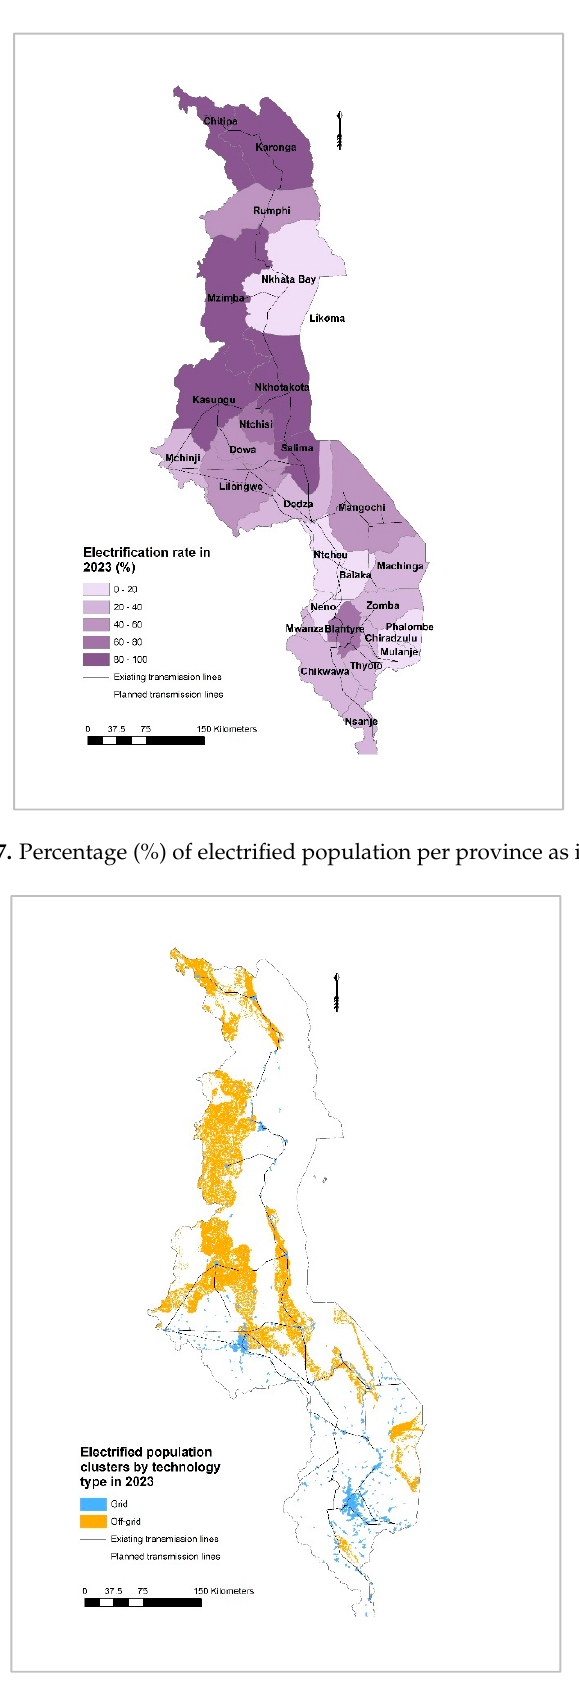
Figure 8. Grid vs. Off-grid split as per 2023 rollout plan estimated to electrify 50% of Malawians.